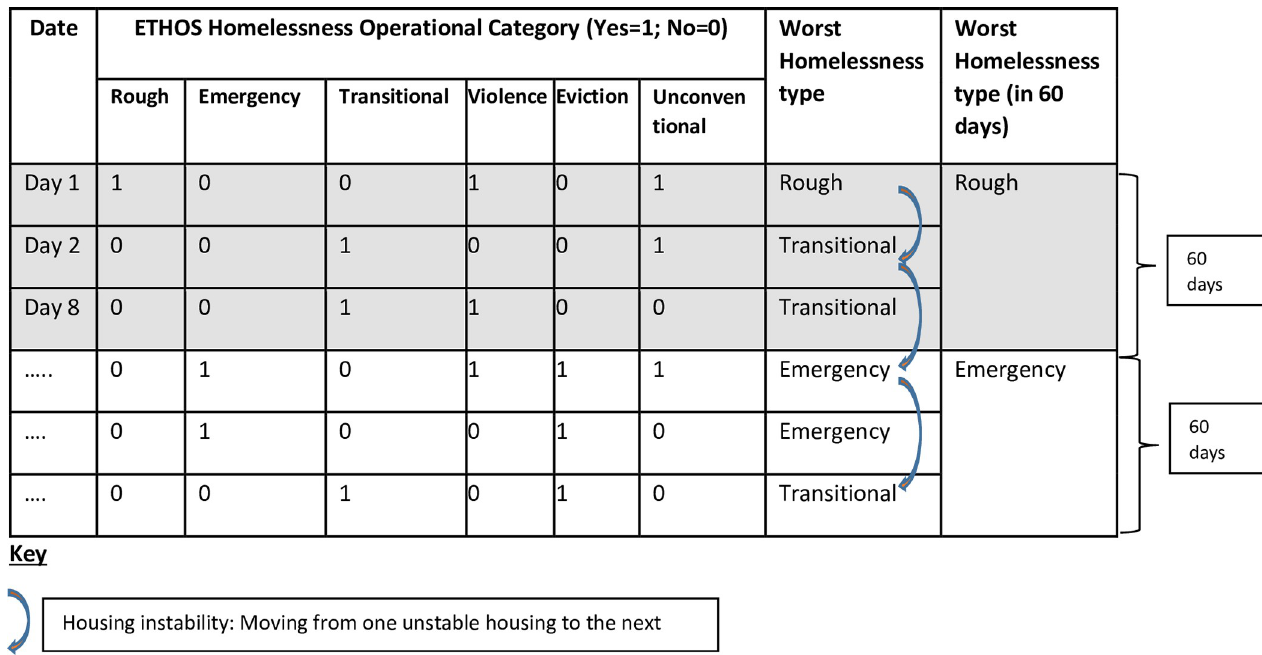
Fig 1. Construction of homelessness and housing instability